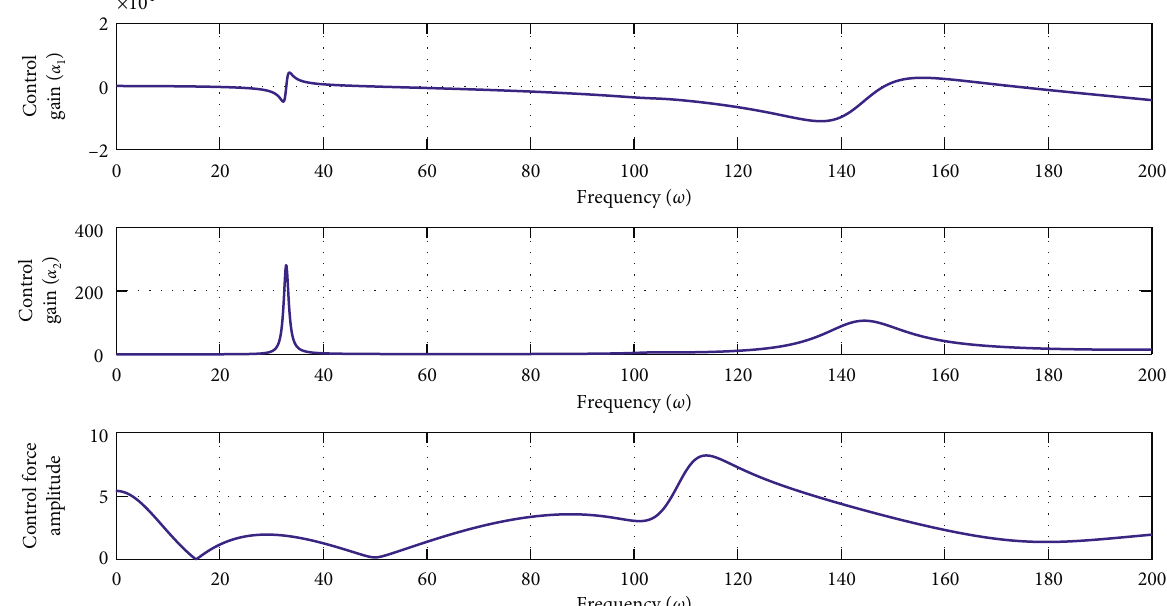
Figure 5: The design plot of the required gains versus the excitation frequency ω / ω